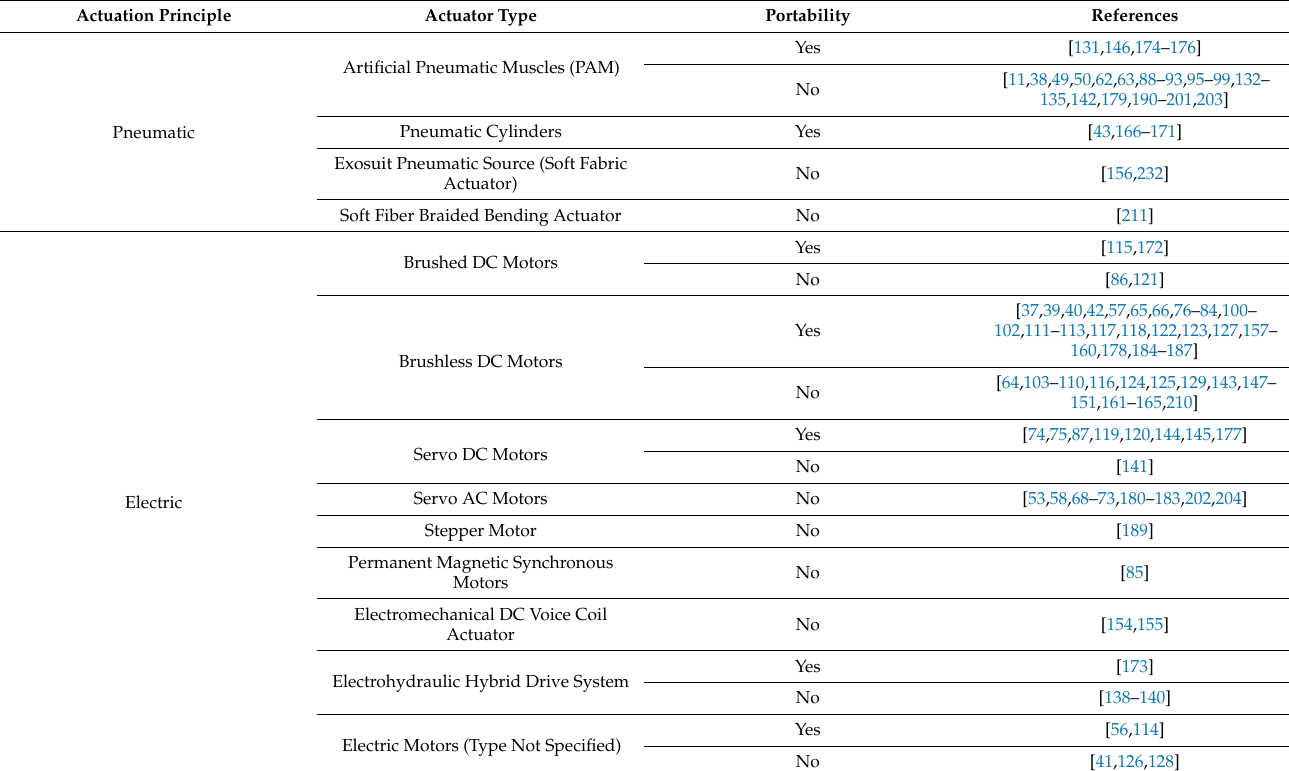
Table 5. Different types of actuators used in PAEs. Portability of the utilized actuation units is assessed based on their size, weight, and energy